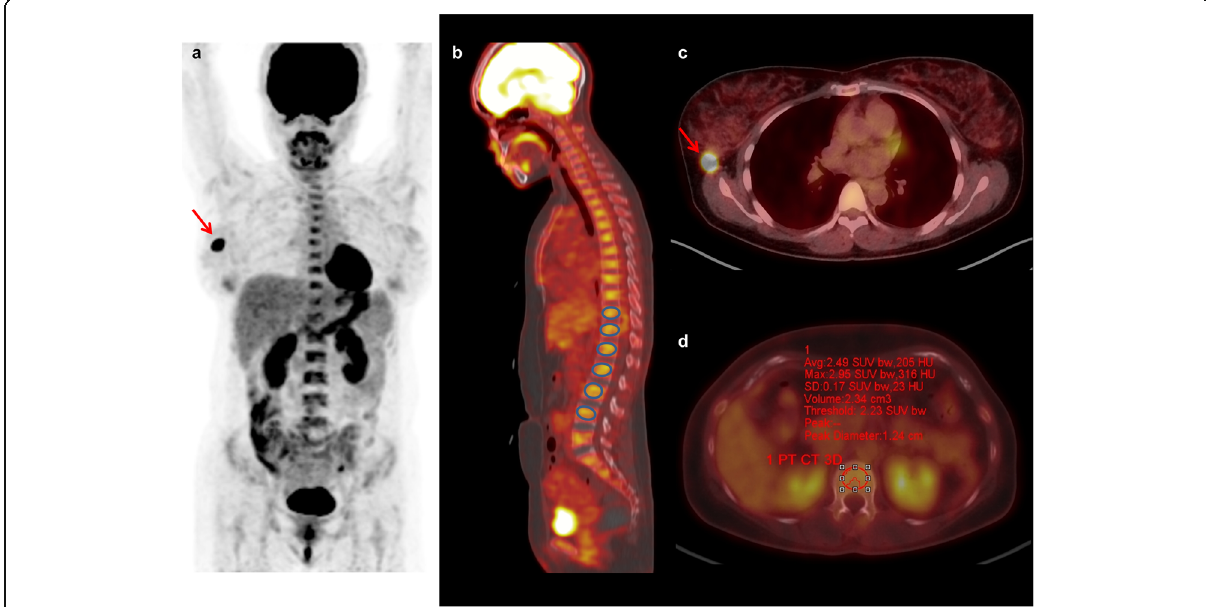
Fig. 1 Maximum intensity projection ( a ), fused coronal PET/CT ( b ), and fused transaxial PET/CT ( c , d ), images of a 41-year-old woman with invasive breast cancer. Primary breast cancer lesion (arrow) showed intensely increased [ 18 F]FDG uptake with maximum SUV of 17.30, MTV of 4.72 cm 3 , and TLG of 28.00 g ( a , c ). Six spheroid-shaped VOIs were manually drawn over the vertebral body of thoracic and lumbar spines ( b ). An isocontour using a cutoff SUV of 75% of the maximum SUV of VOI was automatically produced within each VOI of the vertebral body, and mean SUV of voxels within the isocontour was measured, showing mean SUV of L1 spine of 2.49 ( d ). BM SUV and BLR of the patient were 2.15 and 1.15, respectively. The patient was diagnosed with T2N0 stage and underwent curative surgical resection of the cancer lesion.